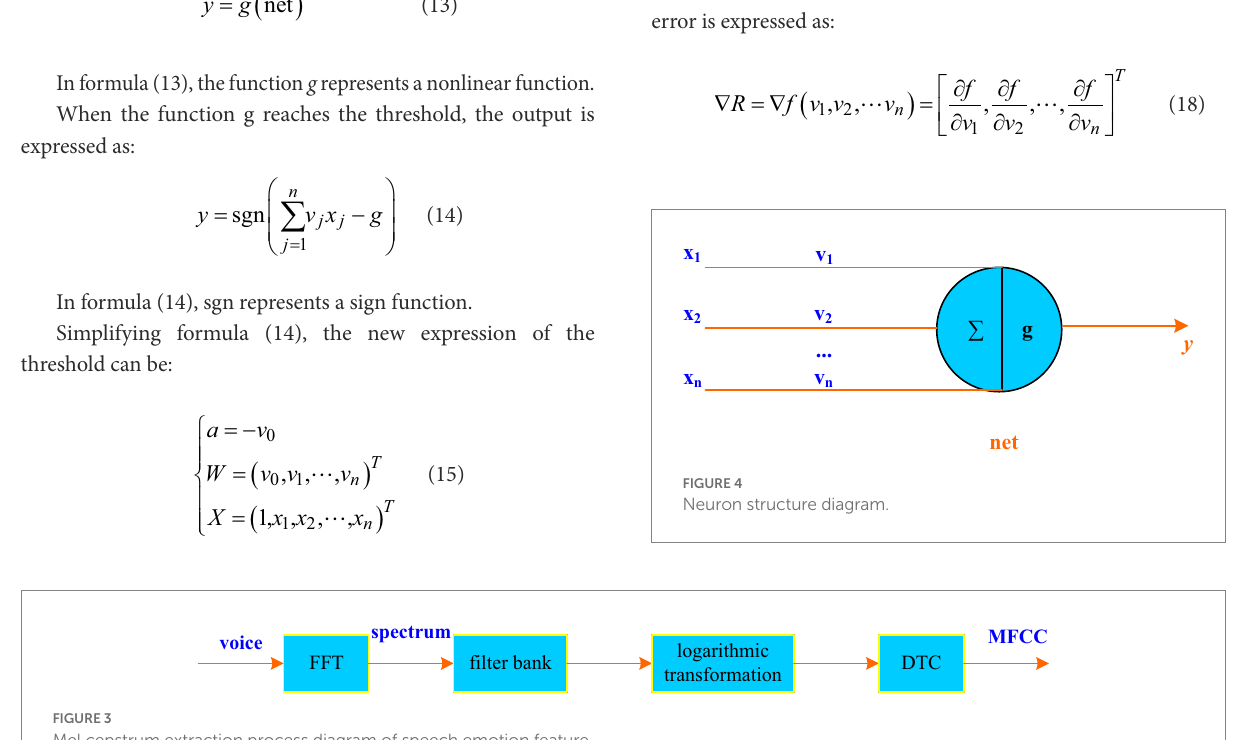
FIGURE 3 Mel cepstrum extraction process diagram of speech emotion feature.